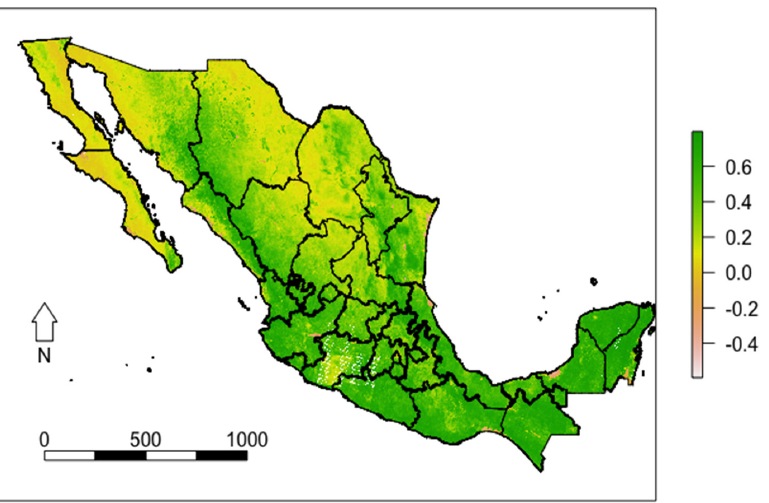
Figure 1. Normalized Difference Vegetation Index (NDVI) of Mexico 2018 values in summer (1 June to September).